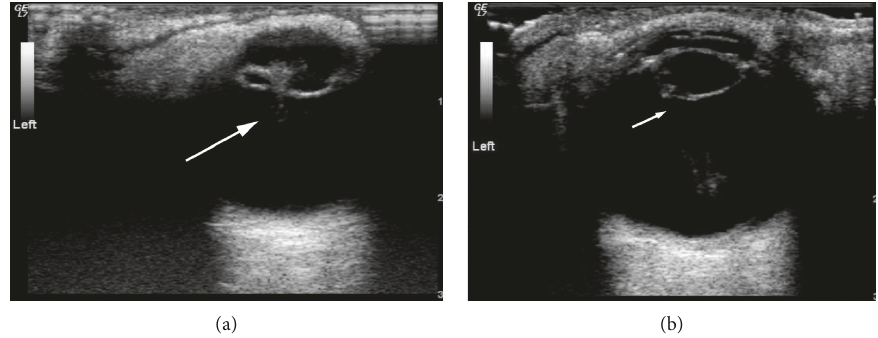
Figure 1: Ruptured PC shown by 14 MHz +THI. (a) A hyperechoic passage is present through the lens to the vitreous body, and the echo of the PC is interrupted (long arrow). (b) The PC shows an irregular oval echo and an uneven echo at the rupture (short arrow).